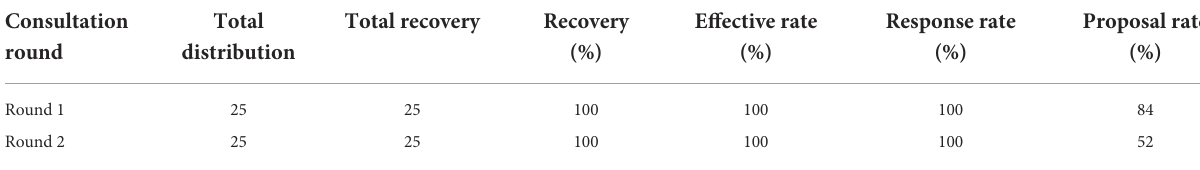
TABLE 2 Questionnaire collection and expert response.